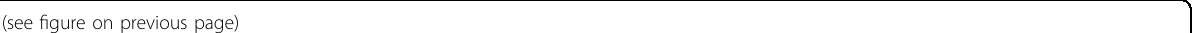
Fig. 5 Caspase activity response to birinapant/chemotherapy treatment is attenuated by simultaneous administration of carboplatin. Caspase 8 ( A , B ) and Caspase 9 ( C , D ) activity was measured after treatment of Caspase 8 WT and Caspase 8 KD cells with carboplatin (6.25 µM), paclitaxel (6.25 µM), and low Birinapant (12.5 µM) for 18 h. Values are arbitrary Caspase units, n = 8. Single asterisk (*) represents p < 0.05, double asterisks (**) p < 0.001, triple asterisks (***) p < 0.0001 based on t test. E – H Similar experiments were carried out using high Birinapant (25 μ M). I Percentage of γ H2A.X-positive cells were measured by immuno fl uorescence in subcutaneous tumors from mice treated as described in Fig. 3. * p < 0.05; ** p < 0.01; *** p < 0.001. J , K γ H2AX response was measured in Caspase 8 WT ( J ) and Caspase 8 KD ( K ) Ovcar8 cells treated with carboplatin (6.25 µM) and/or high birinapant (25 µM) simultaneously for 24 – 48 h as indicated, using the Zeiss Zen Software from NCI Confocal Core Facility. Data are average γ H2A.X foci per cell, n = 100. Single asterisk (*) represents p < 0.05, double asterisks (**) p < 0.01, based on t test. L Western blot analysis of total protein lysates after 18 h single or simultaneous treatment with carboplatin (C, 6.25 µM), birinapant (lo B, 12.5 µM or hi B, 25 µM). Loading amounts were assessed by GAPDH staining and ratios of protein to loading control were calculated using